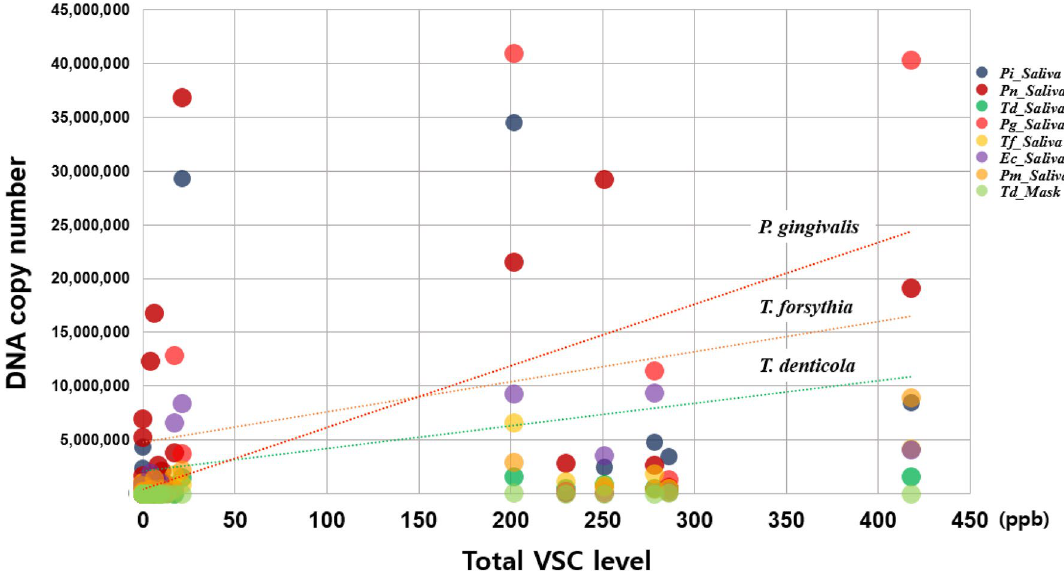
Figure 6. Bacteria positively correlated with increase in total VSC level. Pi: Prevotella intermedia, Pn: Prevotella nigrescens, Td: Treponema denticola, Pg: Porphyromonas gingivalis, Tf: Tannerella forsythia, Ec: Eikenella corrodens, Pm: Parvimonas micra, _Saliva: DNA copy number of each bacterium detected in Saliva , _Mask: DNA copy number of each bacterium detected on the inner surface of the mask.